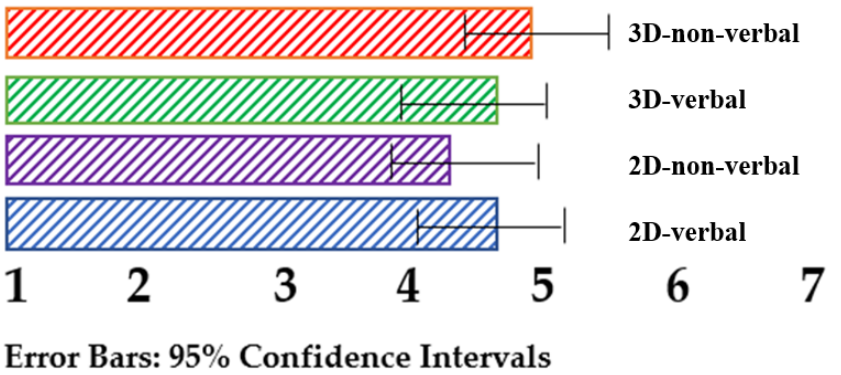
Figure 8. Level of immersion among the four test conditions.